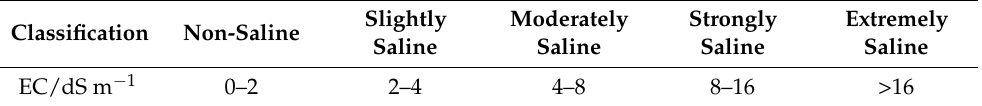
Table 1. Soil salinity classes